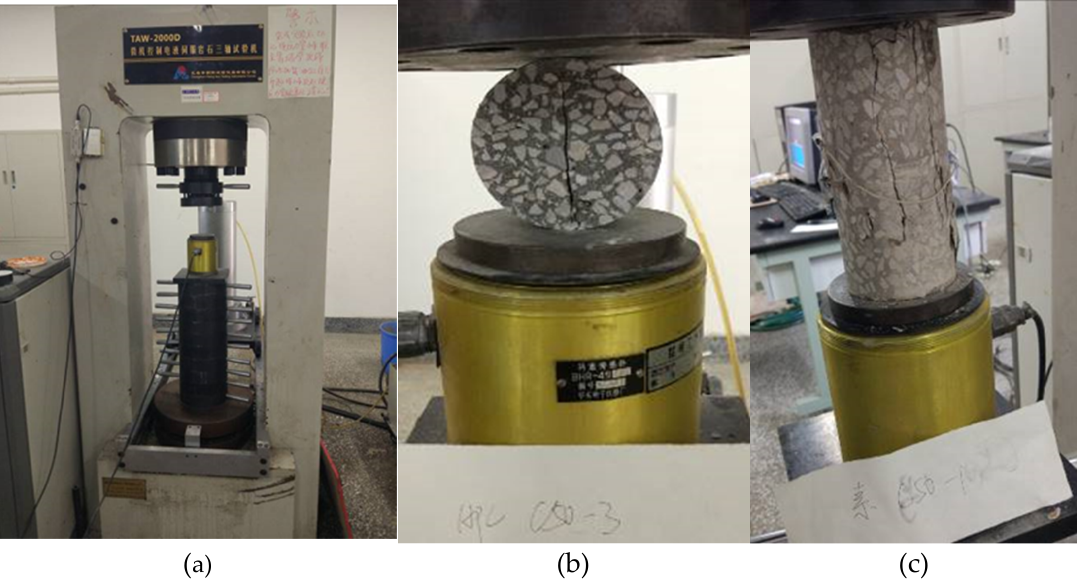
Figure 2. TAW-2000 computer-controlled automatic pressure-testing machine (a) and working conditions (b and c).